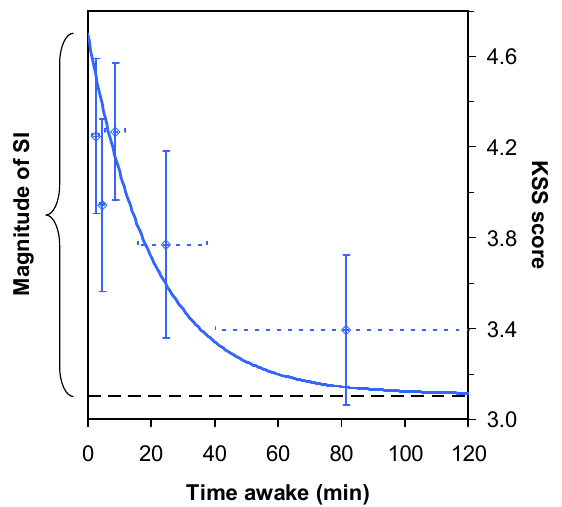
Figure 3. Nonlinear mixed-effects regression model for the KSS-1 administered immediately after